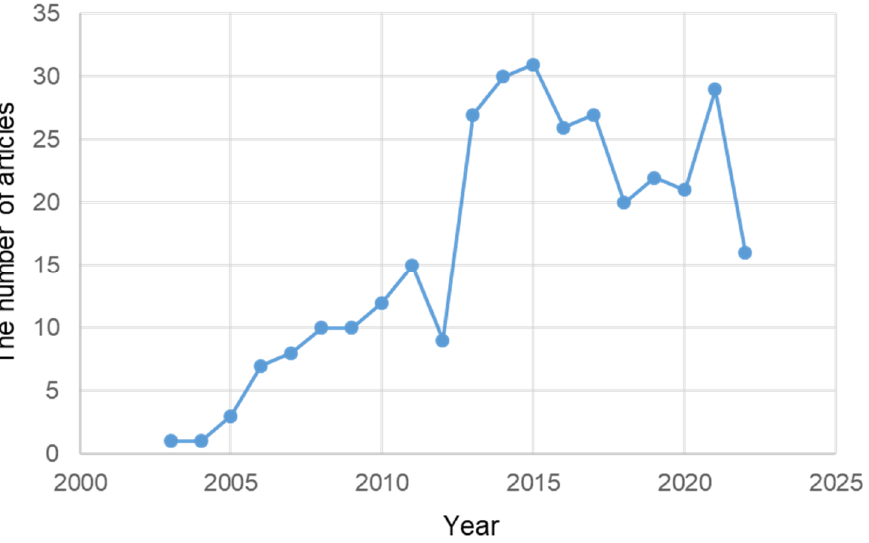
Figure 5. The number of articles related to ER stress in ALS published in PubMed from 2003 to 23 November 2022.